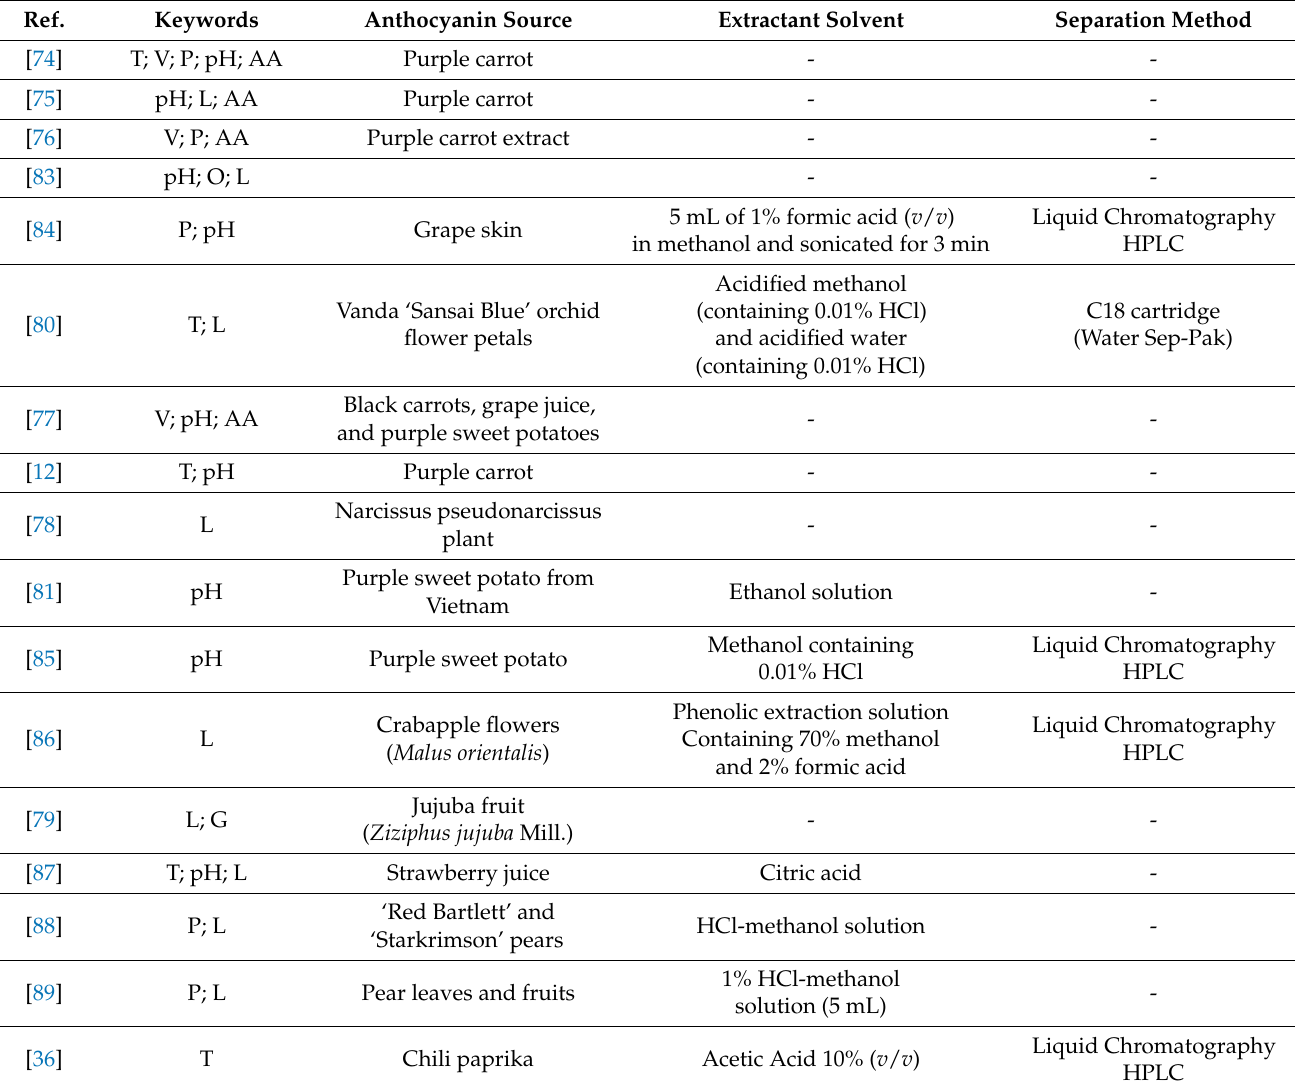
Table 3. Summary of anthocyanin extraction and purification methods. Ref.